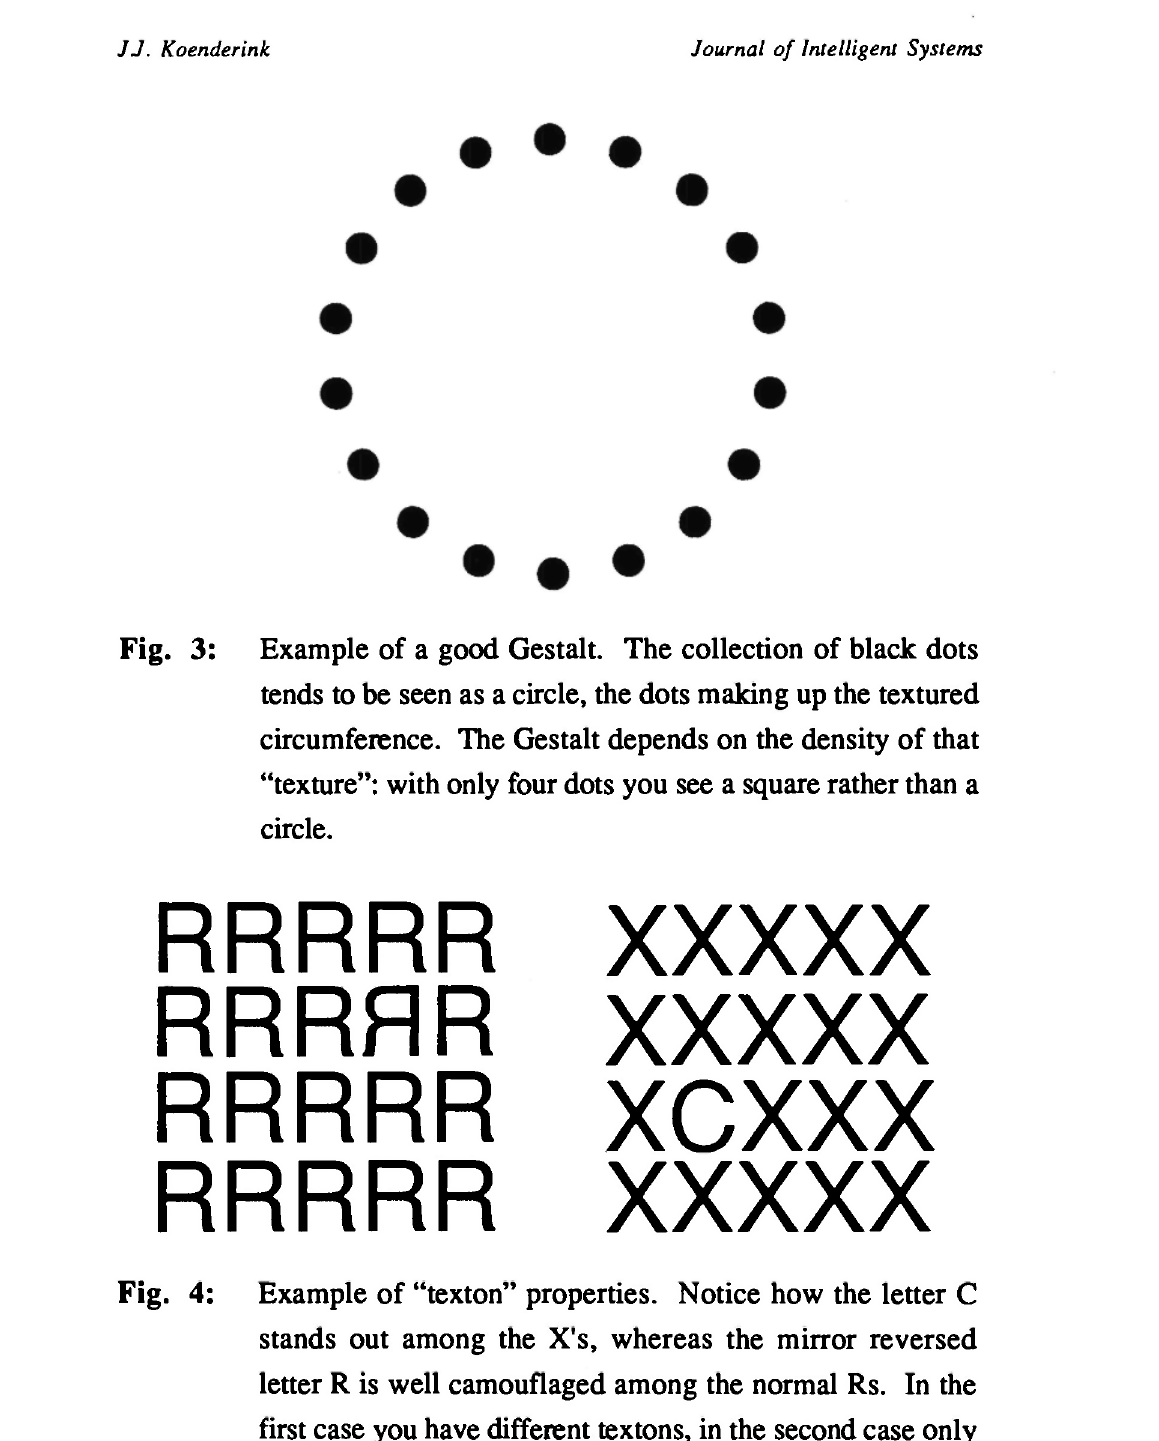
Fig. 4: Example of "texton" properties. Notice how the letter C stands out among the X's, whereas the mirror reversed letter R is well camouflaged among the normal Rs. In the first case you have different textons, in the second case only a single